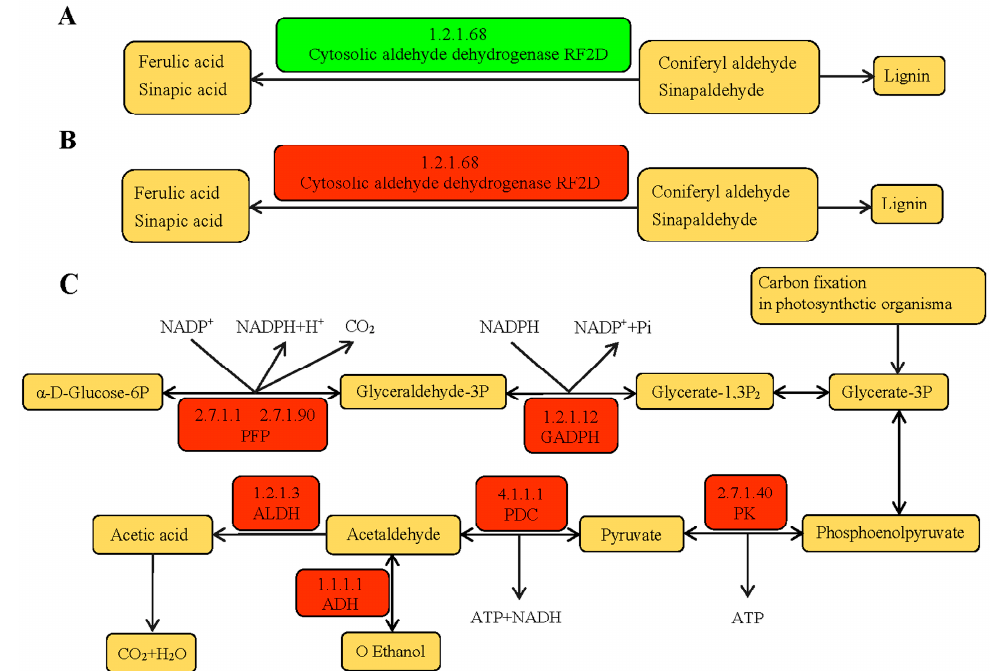
Figure 7. ( A ) Glycolysis / gluconeogenesis pathway. ( B ) Phenylpropanoid biosynthesis pathway in CD vs. CCK. ( C ) Phenylpropanoid biosynthesis pathway in TD vs. TCK. Red boxes represent the up-regulated proteins under simulated drought stress. Green boxes represent the down-regulated proteins under simulated drought stress. Yellow boxes represent metabolites.